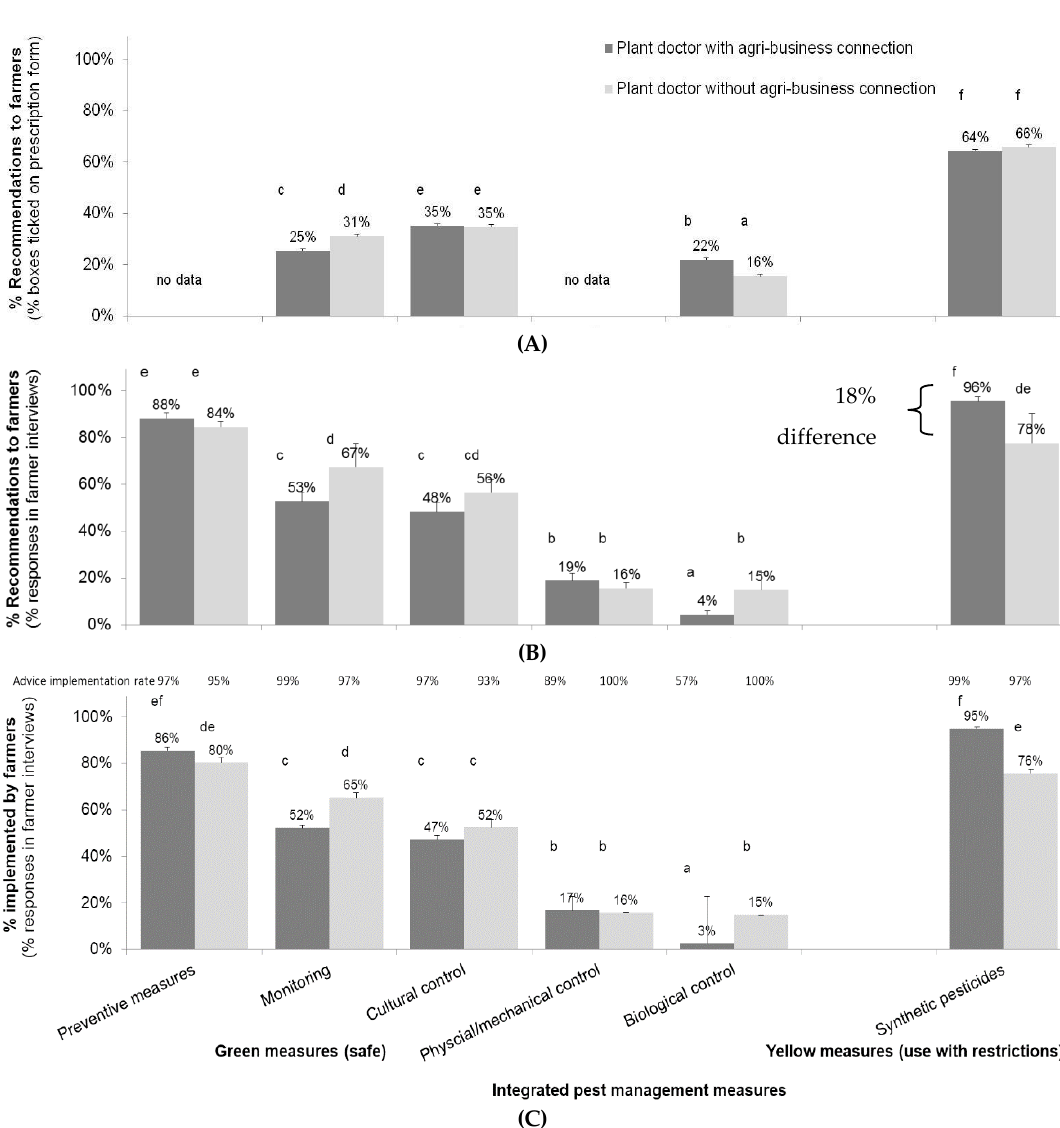
Figure 1. Plant protection recommendations given to growers by agricultural extension workers ( A , B ) and implemented by growers ( C ) depending on the agri-input business linkage of extension workers (here plant doctors) in plant clinics in Beijing municipality, China between 2014 and 2016 ( A ) and 2016 ( B , C ). A = prescription form tick-box data, B and C grower interview data. C shows the rate of implementation of advice of B according to grower statement. Dark grey bars = agri-business-linked, light grey bars = without agri-business linkage, biological control includes macrobials, microbials, safe botanicals, biofertilizers with pesticidial effects and antibiotics, (error bars = SEM, different letters on bars indicate differences according fdr -corrected comparisons using chi-square likelihood ratios at p < 0.05 based on per- plant doctor & clinic session - nested data).